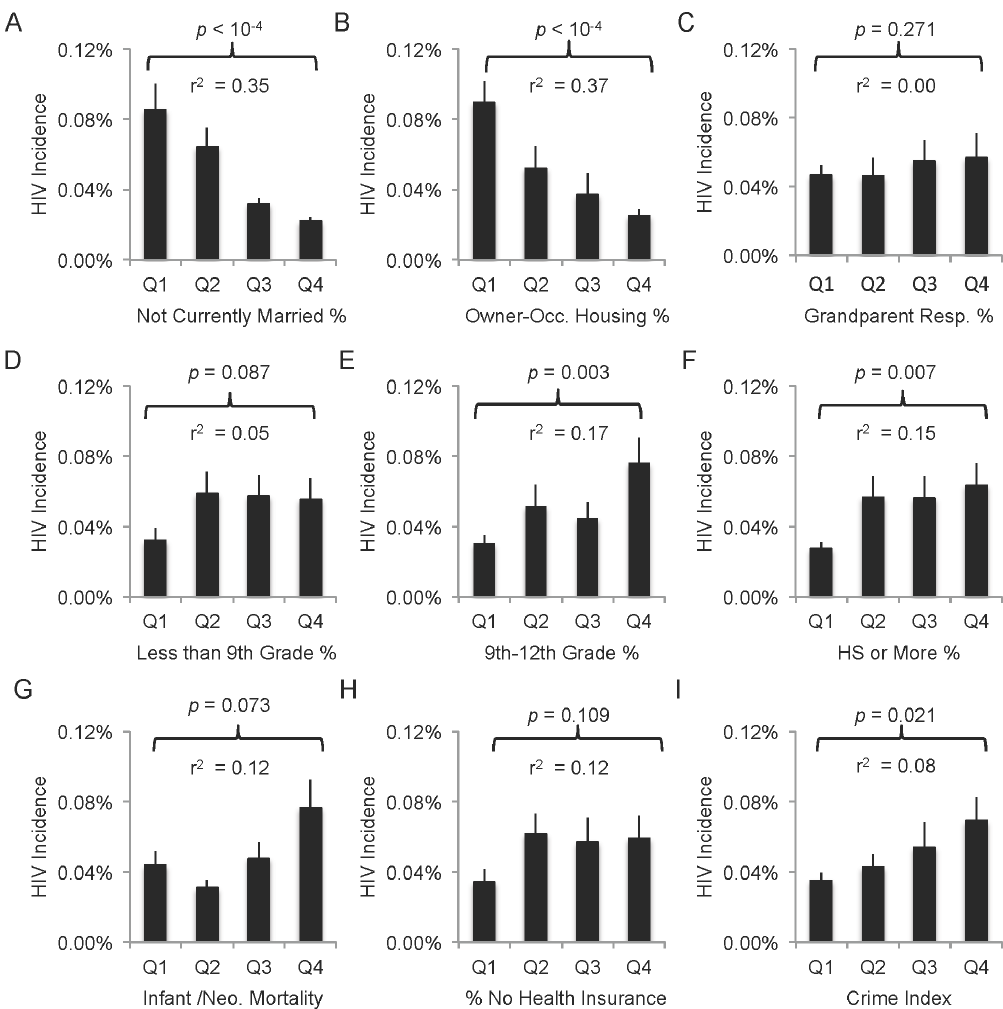
Figure 2. Examples of possible degrees of population-level HIV/socioeconomic associations. Cities were sorted by various 2000 population metrics (x-axes), and the HIV incidence averaged over quartiles, where Q1 represents the average HIV incidence for the 20 cities with the highest values for that census metric and Q4 the average HIV incidence in the 20 cities with the lowest values for that census metric. T-test comparison of the HIV values in first and fourth quarters illustrates that many metrics are associated with HIV incidence (A, B, E, F, I), while others weakly associate (D, G, H) and still others are not likely to be associated (C). Bars=SEM.